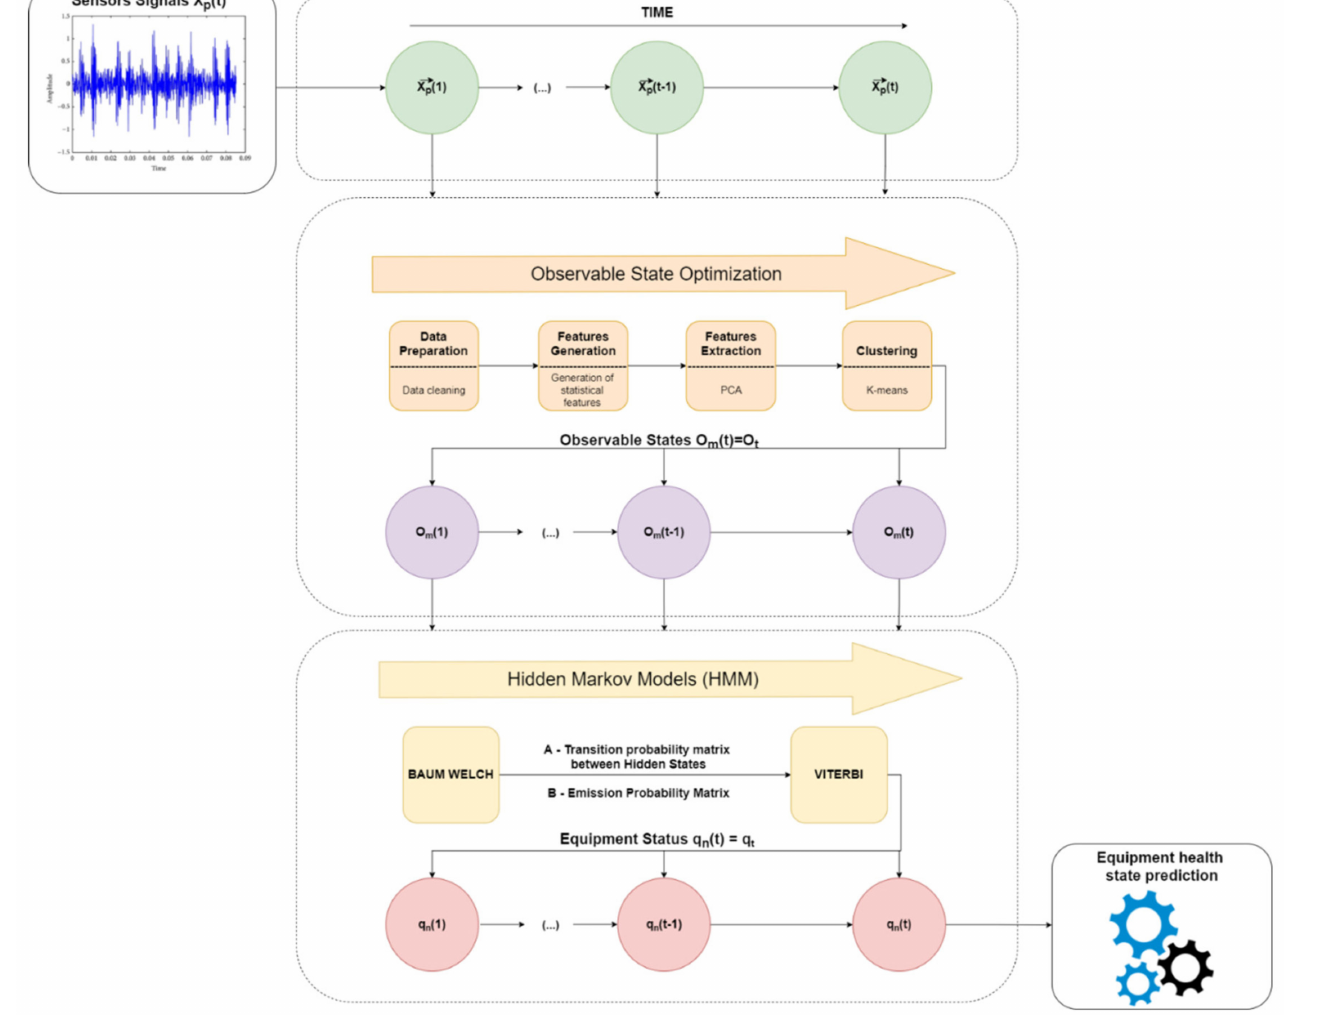
Figure 1. Methodology for observable states optimization to insert into the